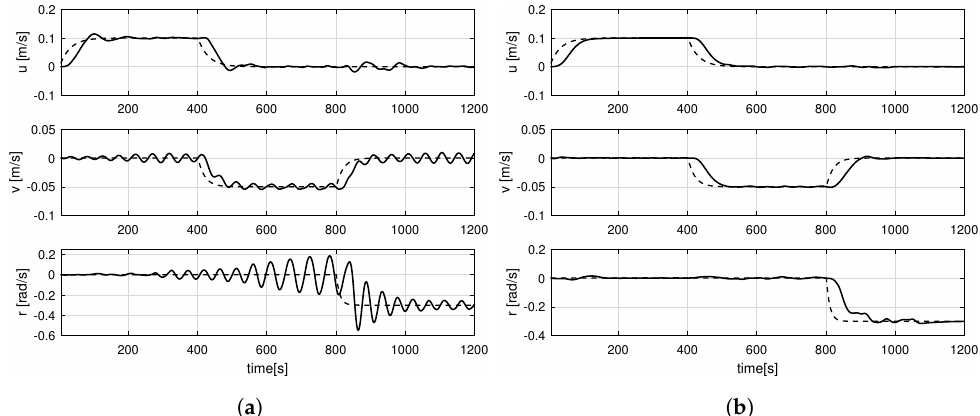
Figure 4. The three components of vessel speed, u , v , and r . Reference value (dashed line), regulated quantity (solid line). For two Pareto optimal solutions: ( a ) γ ∞ = 1.1, ( b ) γ ∞ = 2.1.